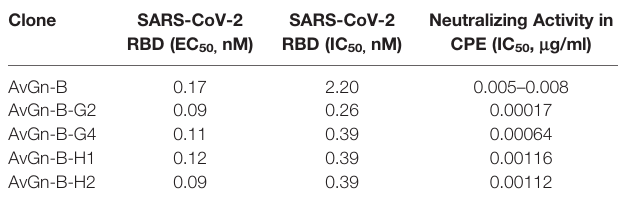
TABLE 2 | Properties of the AvGn-B